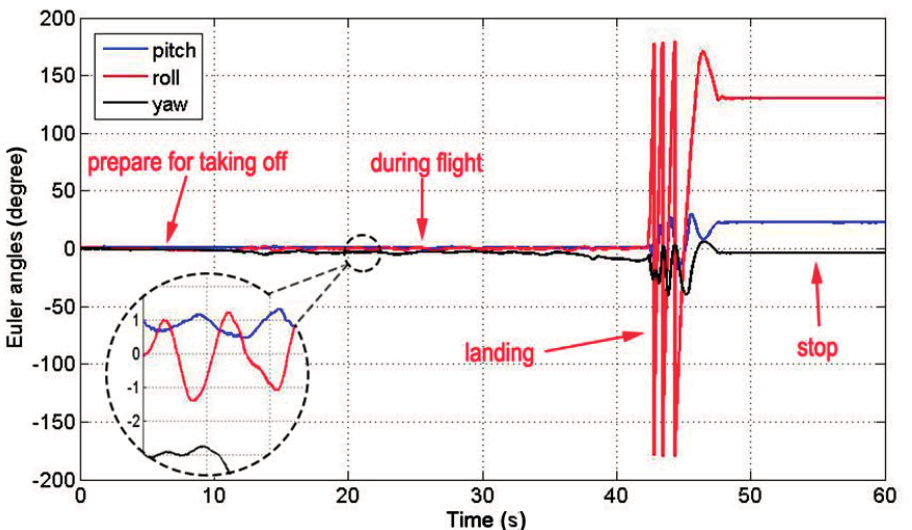
Figure 14. IMU data during one flight.